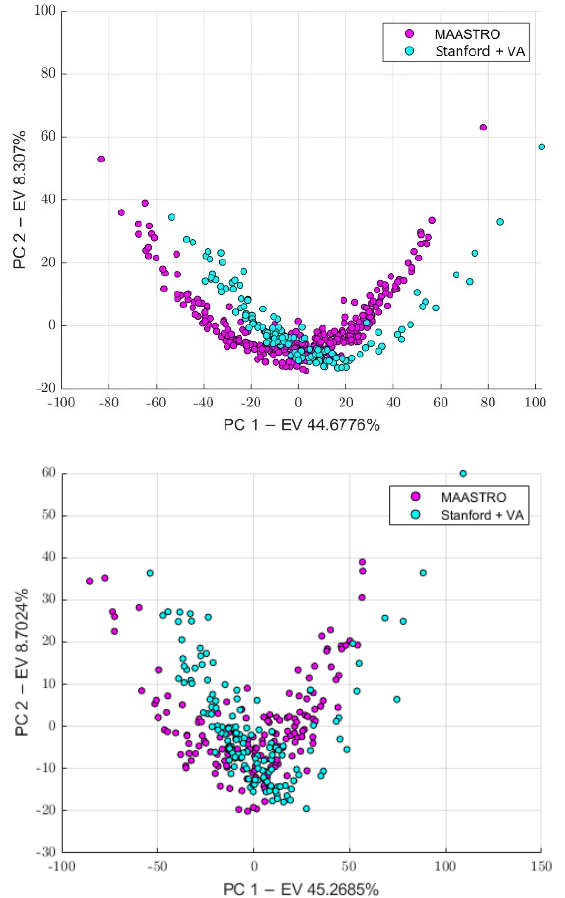
Table 4. Minimum and maximum size subsets for each